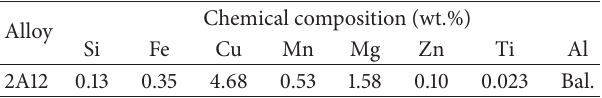
Table 1: Chemical composition of 2A12 aluminum alloy used in this work. Chemical composition Alloy